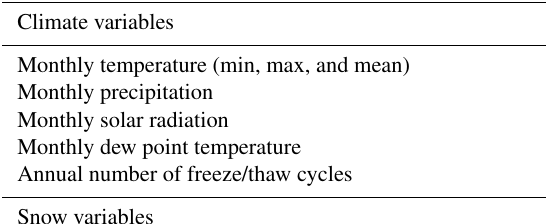
Table 5. Summary climate and snow variables included in the SnowClim dataset. Summary variables are available for pre- industrial, historical, and future time